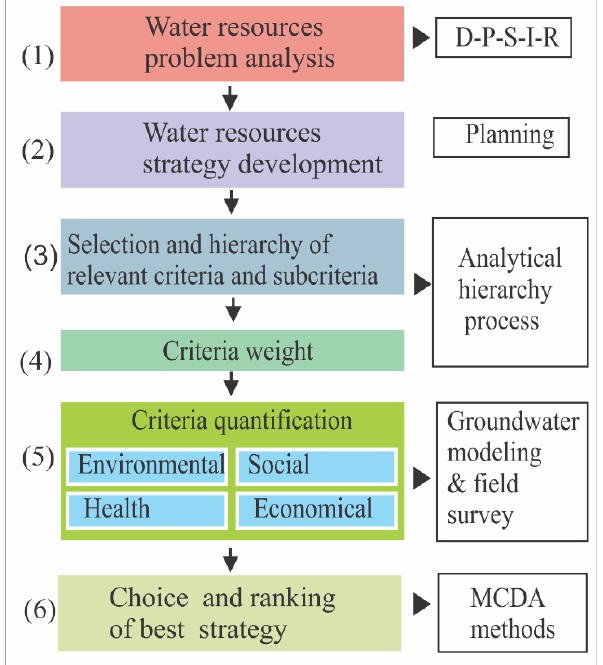
Figure 2. Overall methodology of the